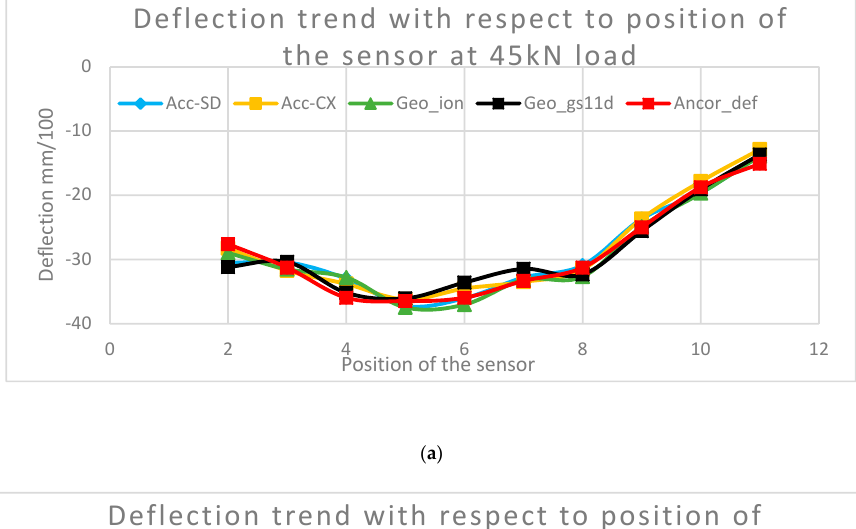
Figure 18. ( a ): Variation of deflections with the loading speed (from 6 to 20 m/s) for load levels 45 kN. ( b ): Variation of deflections with the loading speed (from 6 to 20 m/s) for load levels 55 kN. ( c ): Variation of deflections with the loading speed (from 6 to 20 m/s) for load levels 65 kN. results obtained with all the sensors are very similar.